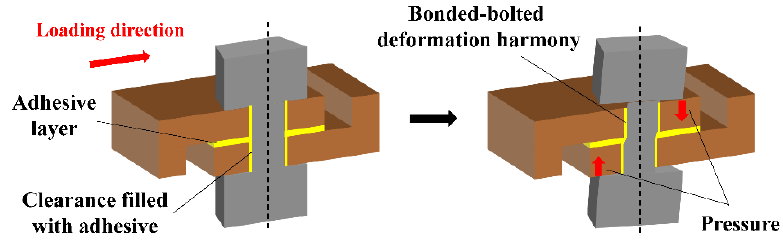
Figure 8. Bolt loading mechanism.